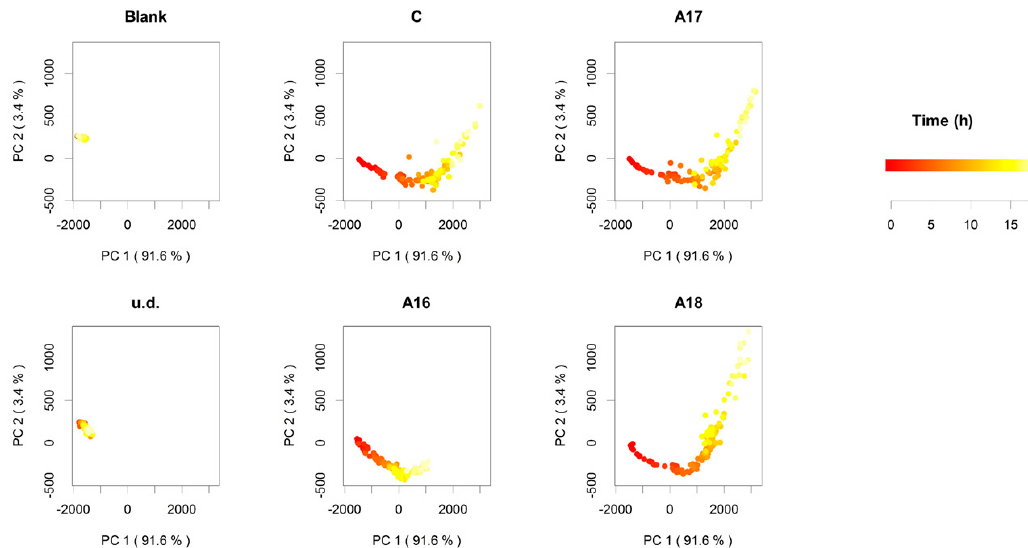
Figure 2. Volatile emission during leavening: principal component analysis of the autoscaled data for five intra-day repetitions for each experimental mode. Score plots for the first two principal components for blank, un-inoculated dough (u.d.), C, and for the three different yeasts, A16, A17, and A18, are depicted. Different color scale, from red to yellow, represents time evolution.